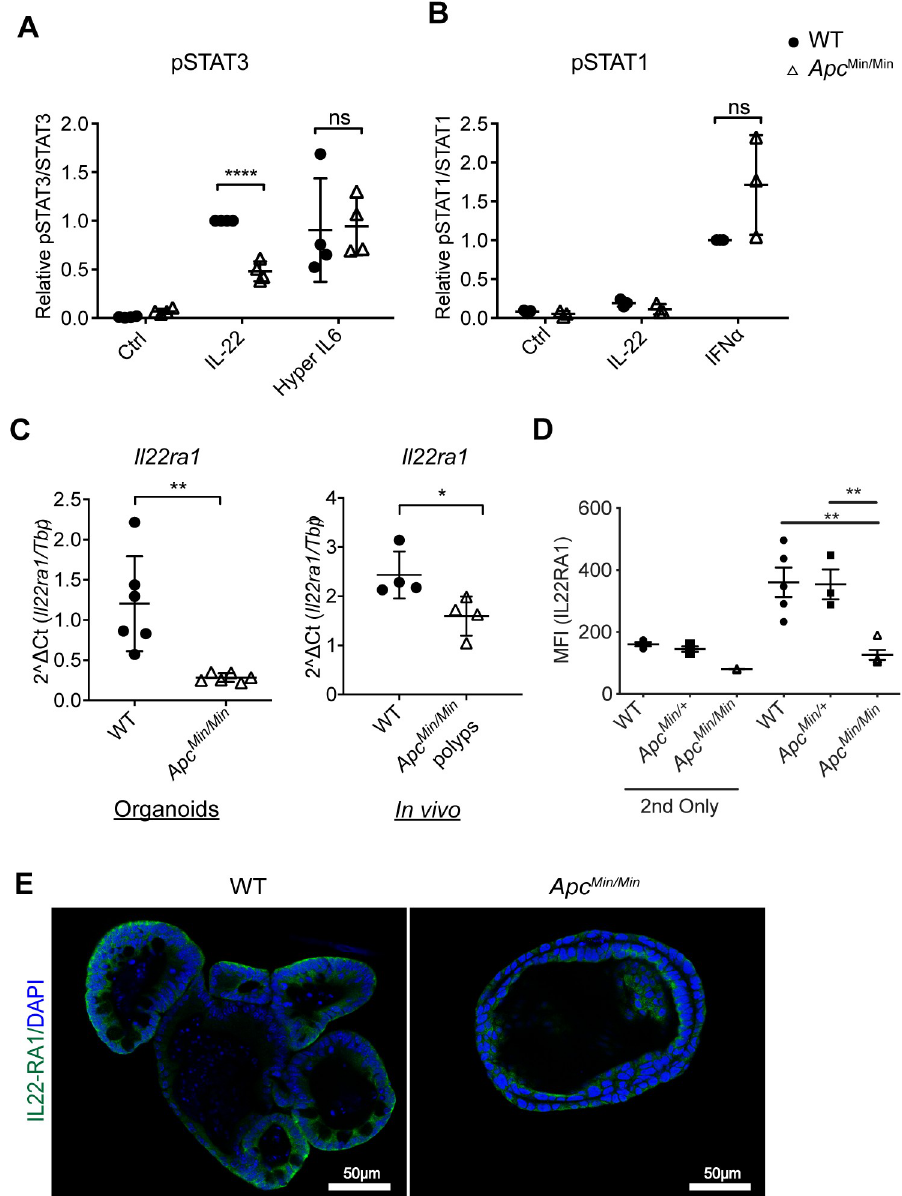
Fig 4. Apc Min/Min organoids lose expression of the IL-22 receptor. (A) Amount of pSTAT3 (Tyr705)/STAT3 in WT and Apc Min/Min organoids stimulated with IL-22 (10 ng/ml) or hyper IL-6 (50 μ M) for 0.5 hours, normalised to that in WT treated with IL-22 in each experiment. �� p < 0.01, paired t test. (B) pSTAT1 (Tyr701)/STAT1 in WT and Apc Min/Min organoids untreated or stimulated with IL-22 or IFN α (1,000 U/ml) for 0.5 hours, normalised to that in WT cells treated with IFN α in each experiment. (C) RT-qPCR analysis of Il22ra1 expression in WT and Apc Min/Min organoids, and in tissue biopsies ( in vivo ) from WT intestines or polyps from Apc Min/+ mice. Organoids, n = 6, tissue, n = 3. � p < 0.05, two-tailed t test. (D) WT, Apc Min/+ , or Apc Min/Min organoids were dissociated, and IL22RA1 expression was measured by flow cytometry. MFI of IL22RA1 staining from 3 biological replicates is plotted. “2nd only” reflects samples that were stained only with secondary antibody (i.e., not exposed to primary antibodies). �� p < 0.01 on one-way ANOVA. (D) WT and Apc Min/Min organoids were fixed and immunostained with IL22RA1 antibodies (green), and nuclei were stained with Hoechst (blue). Numerical values for (A), (B), (C), and (D) are available in S1 Data. Apc, adenomatous polyposis coli; IFN, interferon; IL-22, interleukin-22; IL22RA1, interleukin 22 receptor subunit alpha 1; MFI, mean fluorescence intensity; pSTAT3, phosphorylated STAT3; STAT1/3, signal transducer and activator of transcription 1/3; Tyr705, Tyrosine 705; RT-qPCR, quantitative reverse transcription polymerase chain reaction; WT,